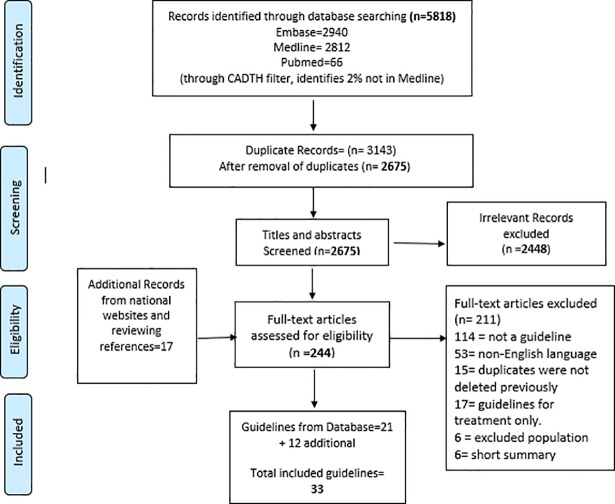
Prisma Flow chart for the selection of the guidelines.